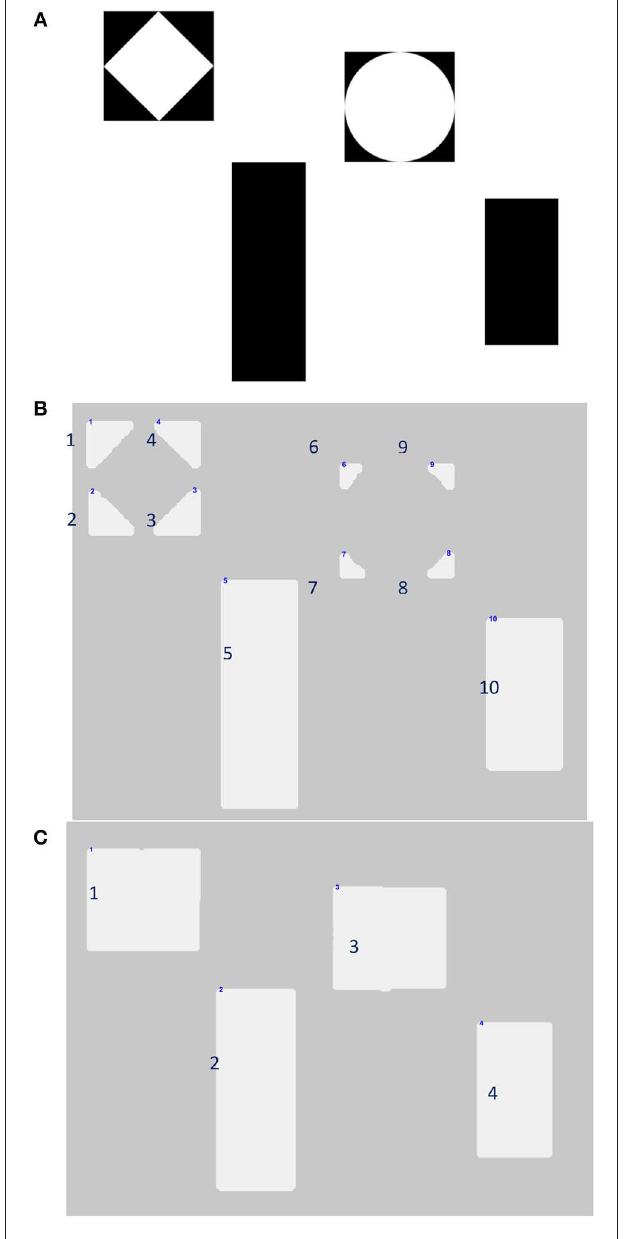
FIGURE 4 | Investigating the effects of thresholding; (A) original image, (B) low thresholding value, (C) high thresholding